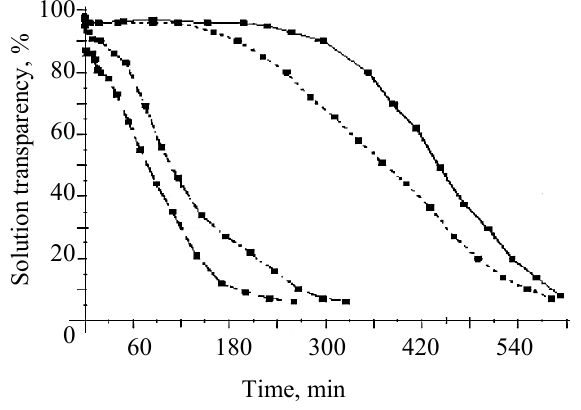
Fig. 1. Change in the transparency of the glucose solution during the nucleation period at 40°C and ΔC = 40 g/100 g of water: ______ a pure glucose solution; with the addition by weight of the solution: – - – propanol 1%; __ . __ the crystals of hydrate glucose 0.01%; ___ ___ propanol 1% + the crystals of glucose 0.01%.